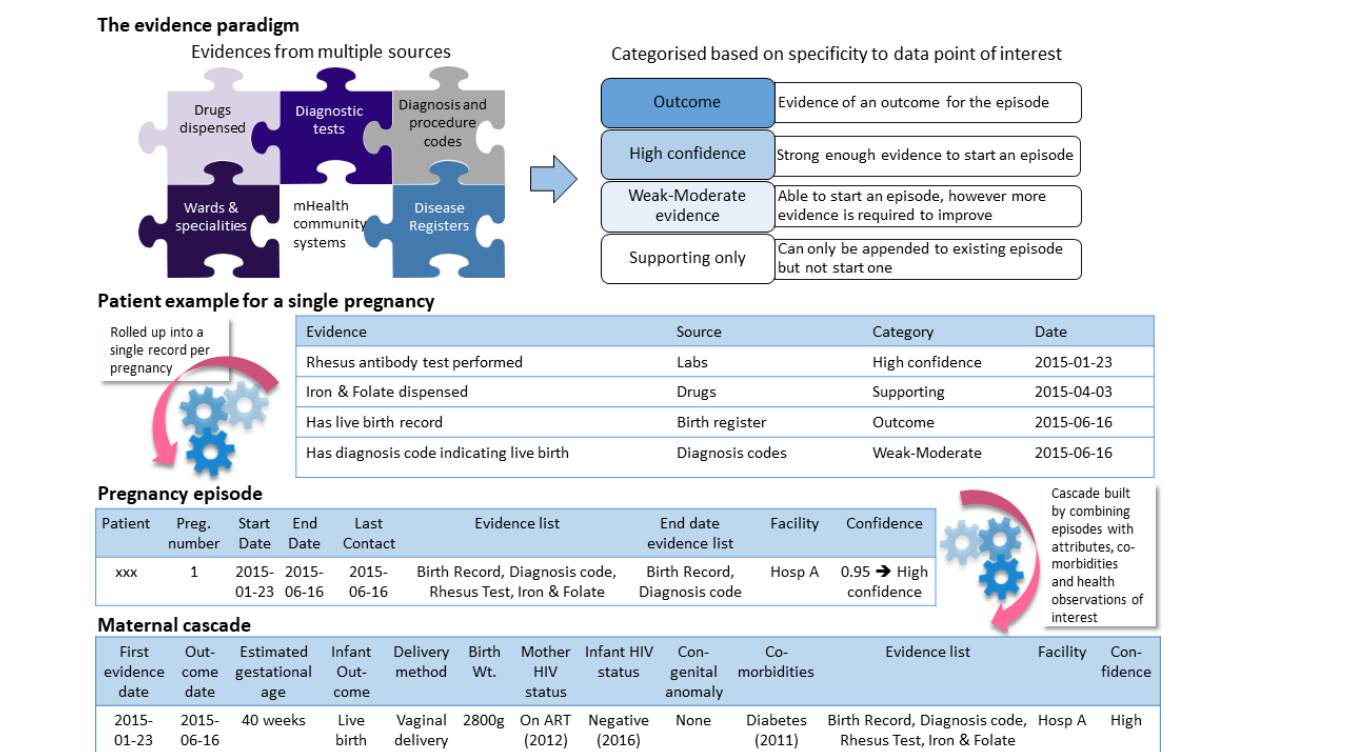
Figure 2: Inference approach for health